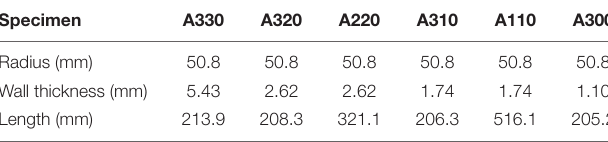
TABLE 2 | Geometry of aluminium alloy 3003-0 cylinders tested by Lee (1962).